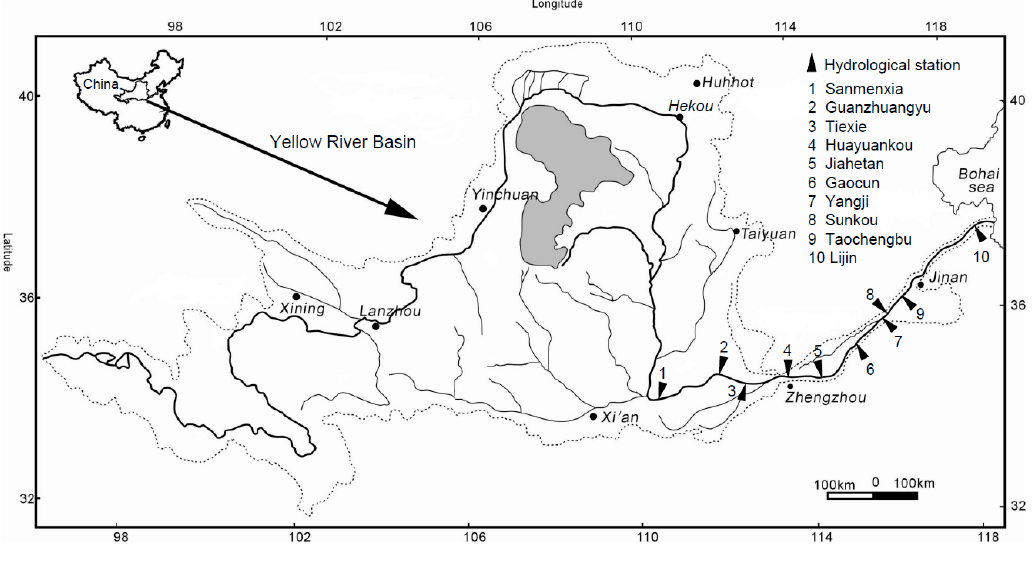
Figure 1. Location of the study area and hydrological stations. Table 1. Physical Characteristics of the Middle and Lower Reaches in the Yellow River Basin [51].